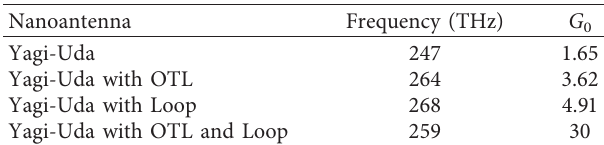
Table 8: Resonance frequency and peak values of gain of the four